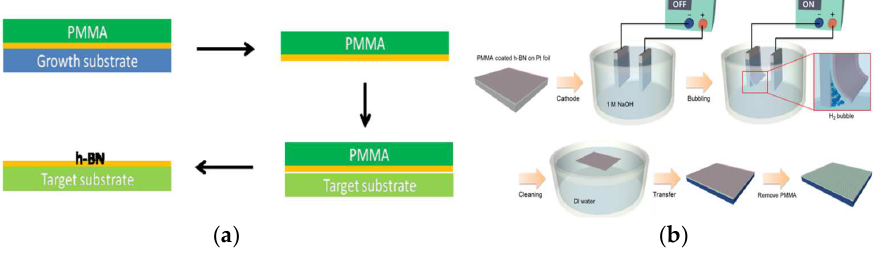
Figure 11. ( a ) PMMA transfer [67]. ( b ) Electrochemical bubbling-based method used to transfer the h-BN layer [68].